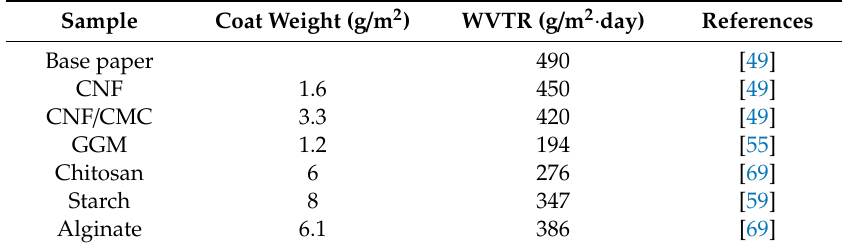
Table 2. Water vapor transmission rate (WVTR) of polysaccharide-coated paper.